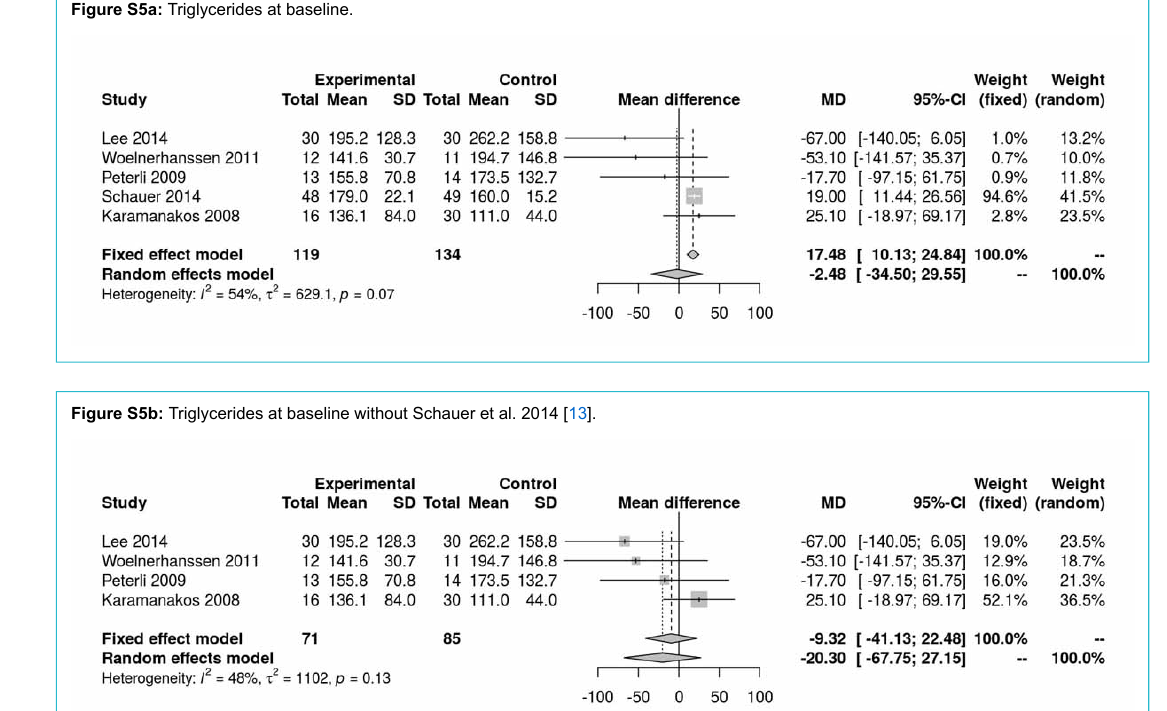
Figure S5a: Triglycerides at baseline.